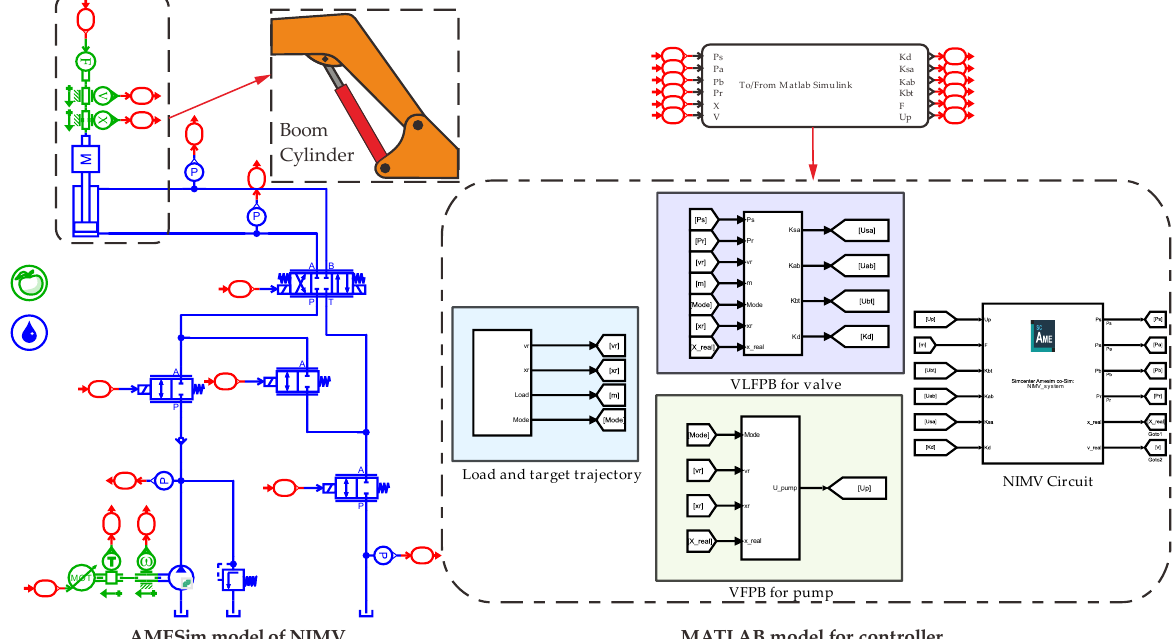
Figure 11. The interface co-simulation of the NIMV system.